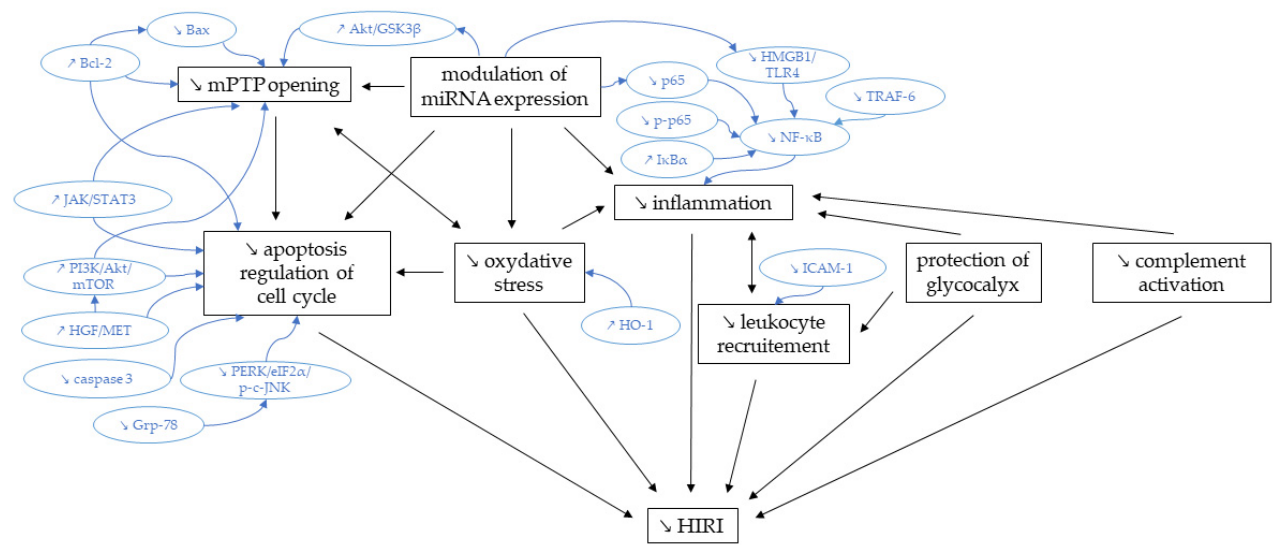
Figure 2. Biological processes involved in sevoflurane protection against HIRI. Akt = protein kinase B; Bax = Bcl-2-associated X protein; Bcl-2 = B-cell lymphoma 2; eIF2 α = Eukaryotic Initiation Factor 2 α ; Grp-78 = glucose-regulated protein 78; GSK3 β = glycogen synthase kinase-3 beta; HGF = hepatocyte growth factor; HIRI = hepatic ischemia-reperfusion injury; HMGB1 = high mobility group box 1; HO-1 = heme oxygenase 1; ICAM-1 = Intercellular Adhesion Molecule 1; I κ B α = NF- κ B inhibitor alpha; JAK = janus kinase; JNK = c-Jun N-terminal kinase; MET = Met tyrosine kinase receptor; miRNA = microRNA; mPTP = mitochondrial permeability transition pore; mTOR = mechanistic target of rapamycin; NF- κ B = Nuclear factor kappa-light-chain-enhancer of activated B cells; PERK = protein kinase R-like endoplasmic reticulum kinase; PI3K = Phosphoinositide 3-kinase; p-p65 = phosphorylated p65; STAT3 = signal transducer and activator of transcription protein 3; TLR4 = toll-like receptor 4; and TRAF-6 = TNF receptor-associated factor 6. A summary of the included experimental studies can be found in table 1. Table 1. Experimental studies .